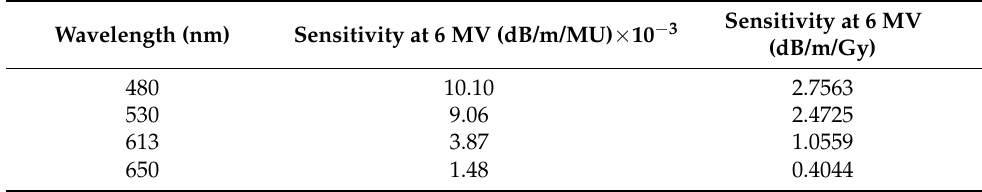
Table 2. Sensitivity of INO fibre at selected wavelengths for fibre irradiated with X-ray beam energy of 15 MV and the estimated dose at 15 MV spectra.